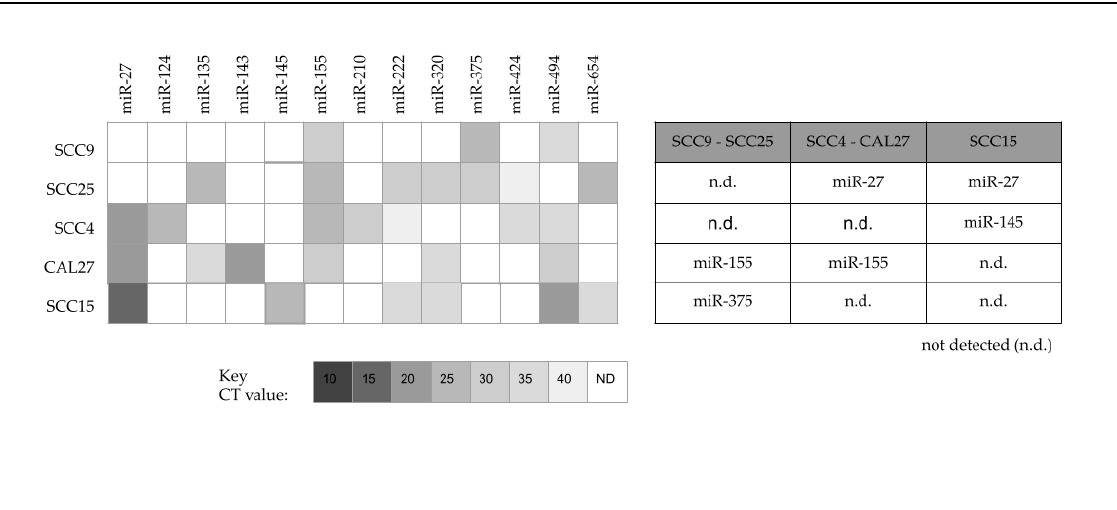
Figure 3. Differential expression of miRNA among oral cancer cell lines. Analysis of the most chemoresistant cell lines (SCC9 and SCC25) revealed differential expression of miR ‐ 375 with no expression of miR ‐ 27. The least resistant cell line (SCC15) exhibited differential expression of miR ‐ 145 with no expression of miR ‐ 155.